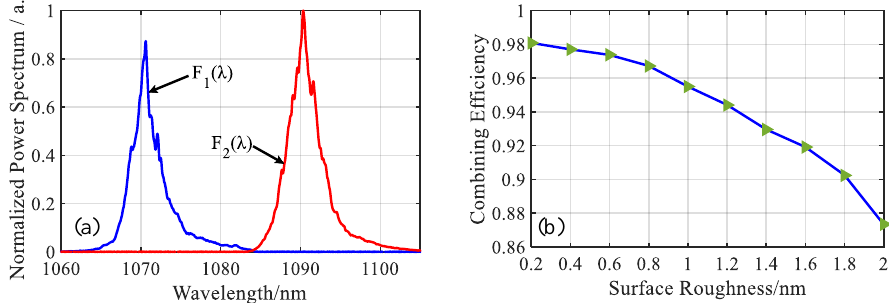
Figure 7. ( a ) The measured normalized spectra of the 1070 nm laser (blue line) and the 1090 nm laser (red line). ( b ) The combining efficiency as a function of the surface roughness.